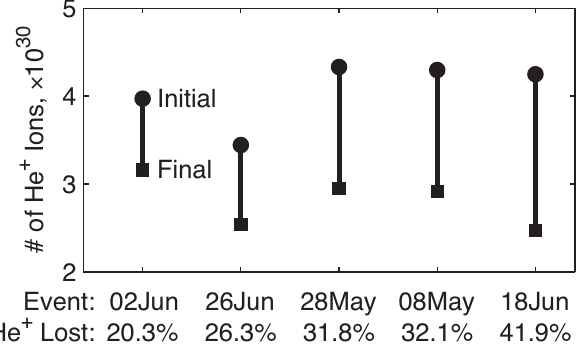
Fig. 3. The initial and final He + abundance as well as the loss percentage for each of the five